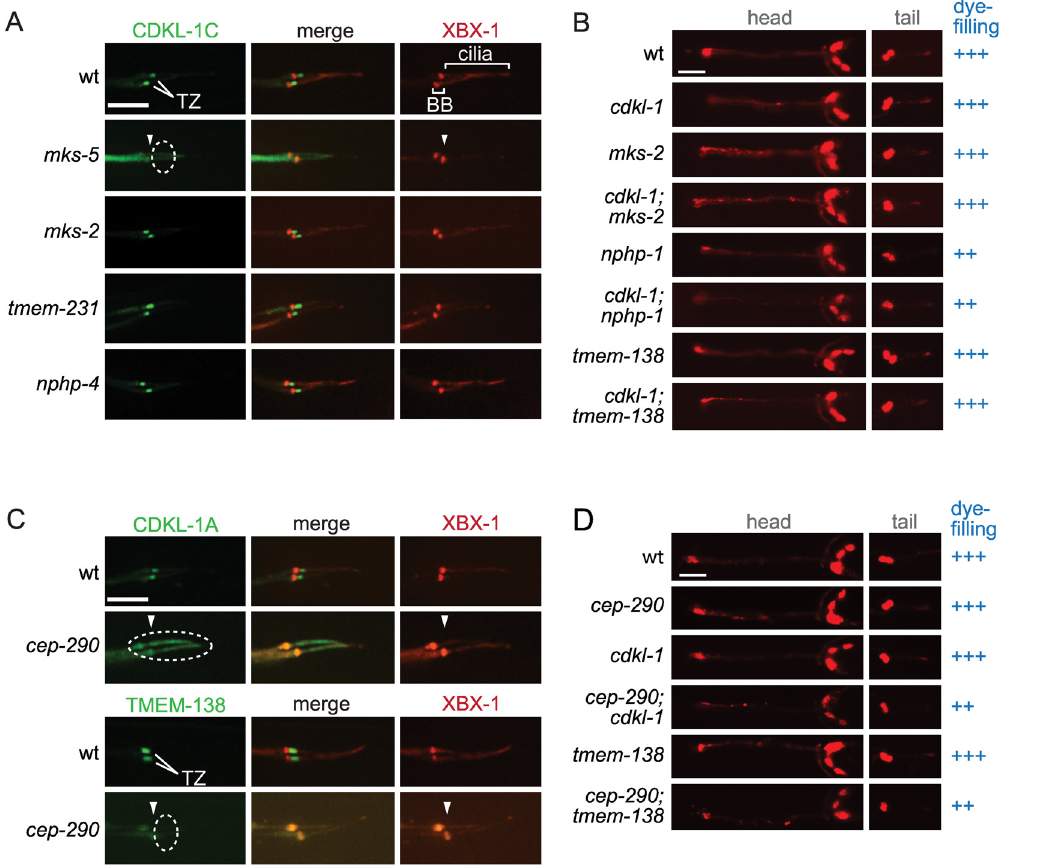
Fig 5. CDKL-1 and TMEM-138 require CEP-290 for their transition zone localisation and are functionally independent of the MKS or NPHP module. ( A ) GFP-tagged CDKL-1 (green) requires MKS-5 (dotted ellipse) but not other “ core ” MKS (MKS-2, TMEM-231) or NPHP (NPHP-4) module proteins for its TZ localisation. XBX-1 is used to mark the basal body-transition fibres and axonemes. Scale bar, 4 μ m. ( B ) Dye-filling assays of head (amphid) and tail (phasmid) sensory neurons reveal that cdkl-1 does not genetically interact (i.e., shows synthetic dye-filling phenotype) with either MKS ( mks-2 ) or NPHP ( nphp-1 ) module mutants. cdkl-1 also does not show a genetic interaction with tmem-138 . Scale bar, 40 μ m. ( C ) Both GFP-tagged CDKL-1 and TMEM-138 depend on CEP-290 for their localisation to the TZ (dotted ellipse). Scale bar, 4 μ m. (D) Partial (weak) dye-filling phenotype in the cep-290;tmem-138 and cep-290;cdkl-1 double mutants (++) compared to wild-type and the individual mutants (normal dye-filling, +++).